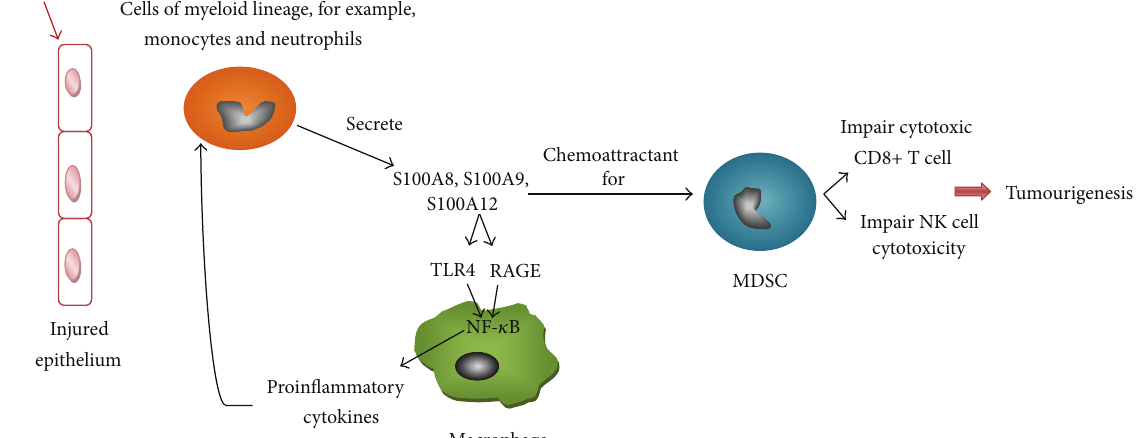
Figure 4: The calgranulins, S100A8, S100A9, and S100A12, are secreted by cells of the myeloid lineage such as neutrophils and monocytes. They bind to TLR4 and RAGE on macrophages and activate the NF- 𝜅 B signalling pathway which leads to the production of proinflammatory cytokines. The production of proinflammatory cytokines then provides a positive feedback by promoting the recruitment of more neutrophils and monocytes. S100A8 and S100A9 are also chemoattractants for MDSCs. MDSCs which move from bone marrow to peripheral blood cause immune suppression and enhance tumourigenesis by impairing cytotoxic CD8+ T cell and NK cell